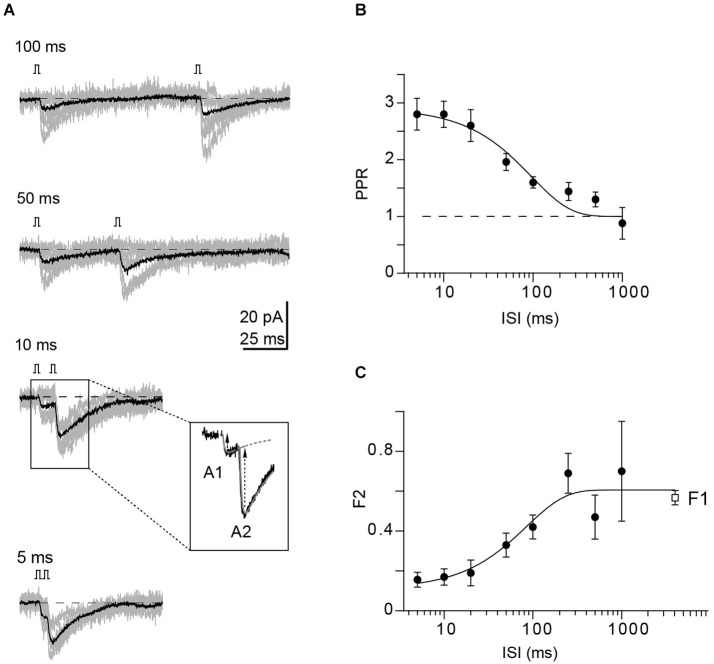
Properties of connected GC-PN pairs in the WT. (A) Example of a paired-pulse experiment at denoted ISI from a unitary GC-PN connection (individual traces in gray; average, including failures, in black). Inset: EPSC amplitudes (black arrows) were determined by fitting products of two exponentials (dashed black lines) to the currents, allowing for subtracting the decay of the first EPSC (A1) from the peak of the second EPSC (A2). (B) PPRs plotted against the indicated ISI (mean ± SE, n = 12). The solid line represents an exponential fit to the data (τ = 96 ms; χ2 = 1.435). (C) Fraction of synaptic failures in the second response (F2) plotted vs. the indicated ISI (mean ± SE, n = 12). The fraction of synaptic failure in the first response (F1 = 0.57 ± 0.04, n = 16) is plotted at the interval between successive recordings (5 s). Solid line represents exponential fit to the data (τ = 85 ms; χ2 = 0.621).